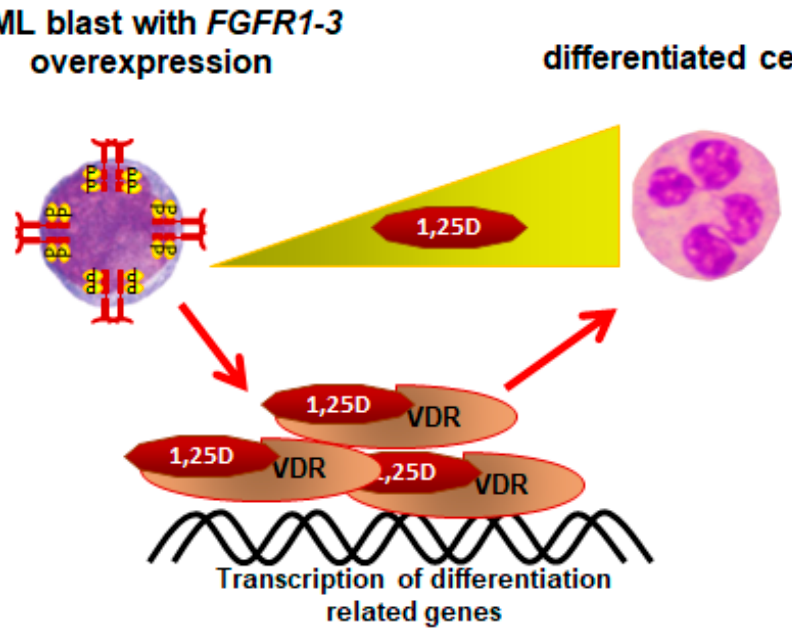
Figure 5. Differentiation of AML blasts with FGFR 1-3 overexpression. The AML blasts with overexpression of FGFR 1-3 produce more VDR protein than wild-type cells, and therefore are more susceptible to 1,25D-induced differentiation.